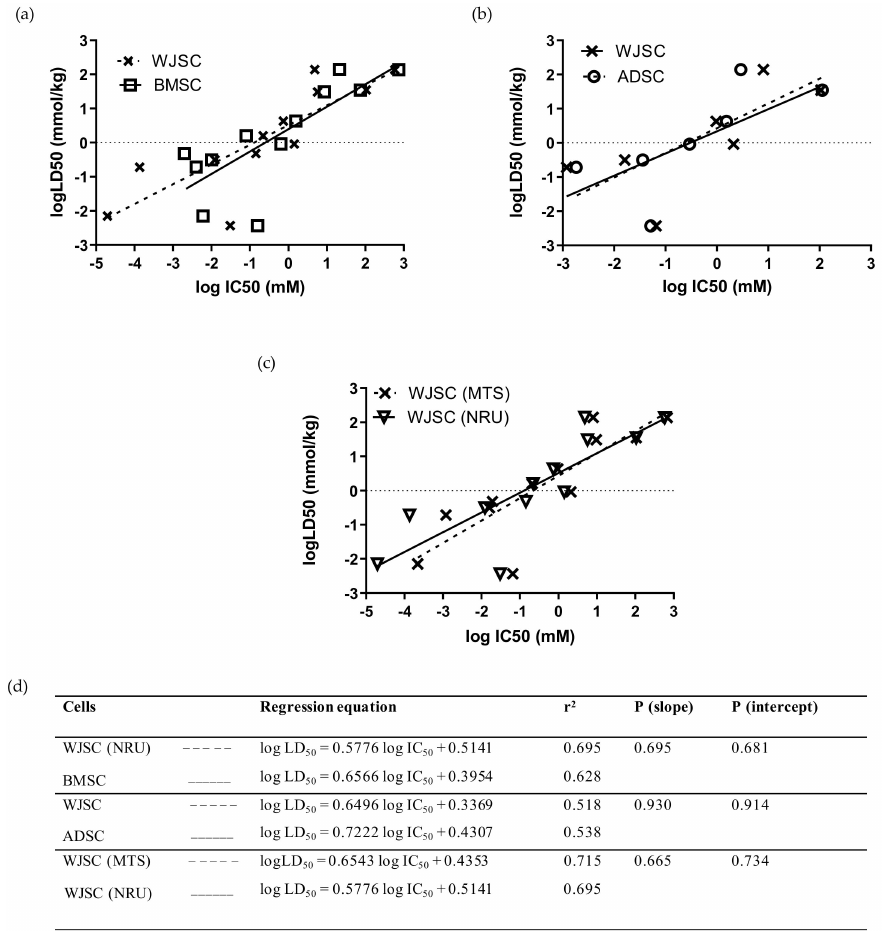
Figure 4. Comparison of linear regressions of human fetal WJSCs with two types of human adult MSCs: ( a ) Comparison with BMSCs for the full panel of 12 chemicals using the NRU assay. ( b ) Comparison with ADSCs for a subgroup of seven selected chemicals (mercury(II) chloride, sodium arsenite, sodium dichromate dihydrate, sodium fluoride, propranolol hydrochloride, potassium chlo- ride, and sodium hypochlorite) by means of MTS assay. ( c ) Comparison of the linear regressions generated by evaluating the toxicity of 12 chemicals on WJSCs using the MTS and NRU assays. The regression data presented here were generated by independent in vitro experiments in our lab, except for data regarding BMSCs and LD 50 values, which were derived from the work by Scanu et al. [14] and by the ICCVAM validation study [6], respectively. Linear regression plots (top panel) are shown as dashed lines with data points marked as “x” symbols (WJSCs), solid lines with open squares (BMSCs), and dashed lines with open circles (ADSCs). ( d ) Regression parameters in tabular format for each of the regression graphs. In all cases, regressions did not differ significantly ( p > 0.05,